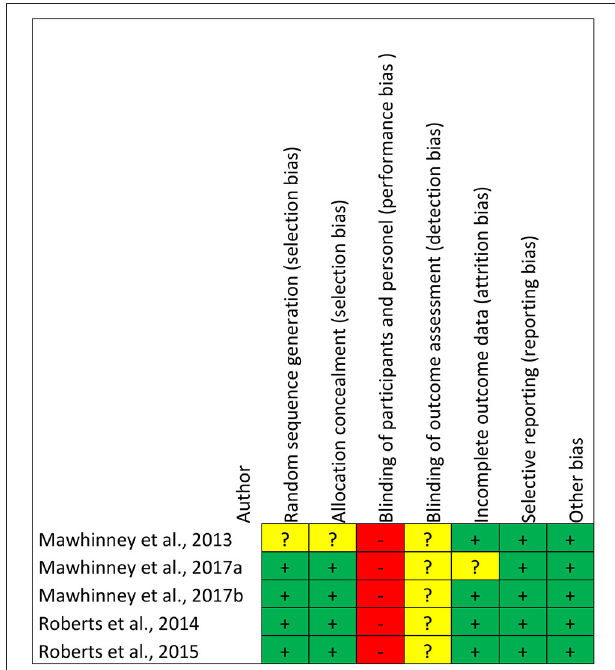
FIGURE 2 | Risk of bias graph for the n = 5 included randomized studies ( n = 1 non-randomized study not included).